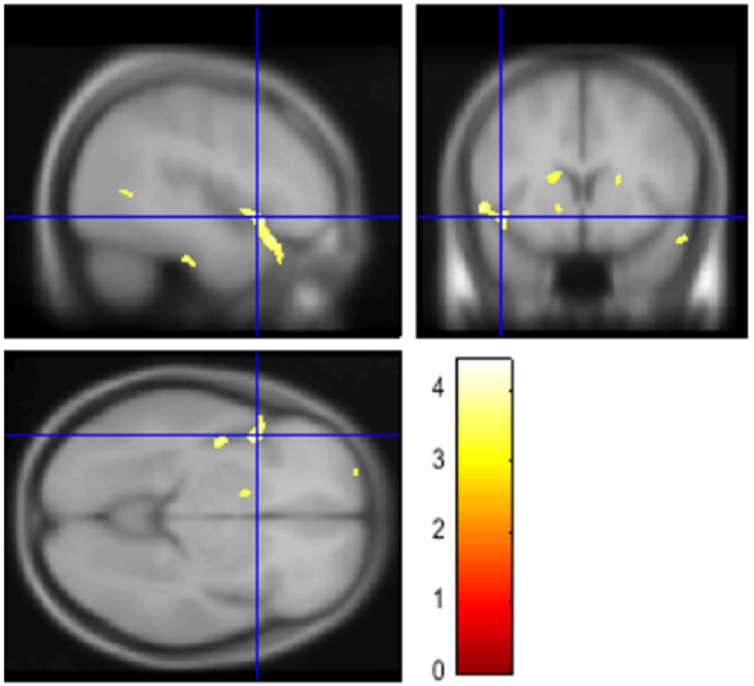
Figure 1. The diagnosis effects (MDD vs. HS with the s/s genotype of 5-HTTLPR). The SPM 45 is displayed on the T1 weighted MRI. The volume of the left insula lobe was smaller in MDD patients than in HS (FWE- corrected p = 0.049, T = 4.40). The color bar represents the range of the T -value.